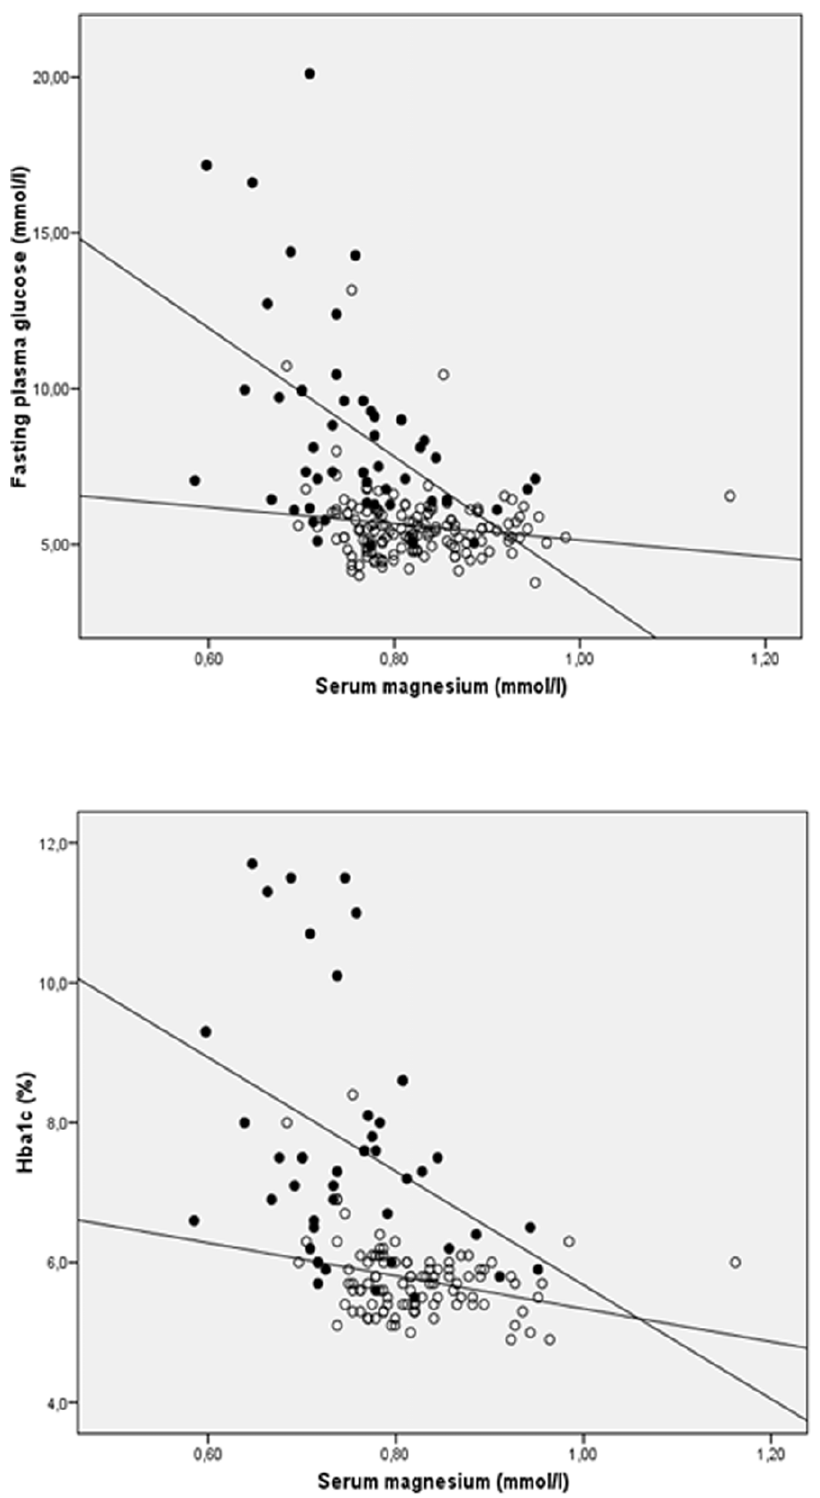
Figure 1. Linear correlations of fasting plasma glucose and HbA1c with serum magnesium in the whole population from the cross sectional case-control study. White circles, non-diabetic patients (fasting plasma glucose: r= 2 0.155, p=0.059; HbA1c: r= 2 0.302, p=0.002); black circles, type 2 diabetic patients (fasting plasma glucose: r= 2 0.484, p , 0.001; HbA1c: r= 2 0.389, p=0.010).